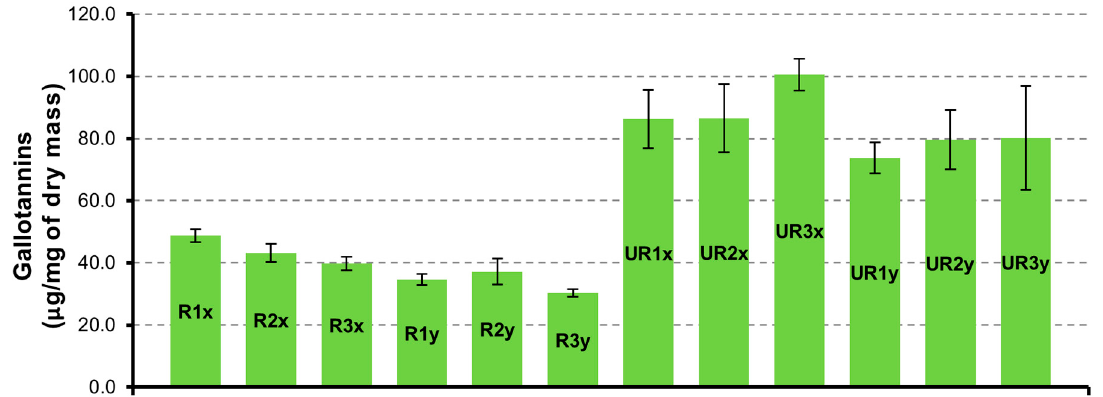
Figure 5. Gallotannins quantification in CAR-R and CAR-UR extracts 1 (24 h), 2 (48 h) and 3 (72 h) time of drying; x (3 h) and y (6 h) time of extraction.